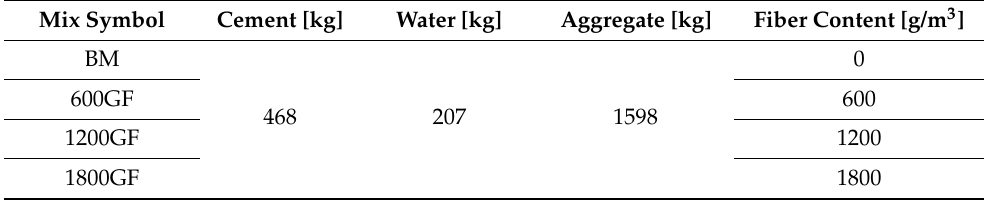
Table 4. Mix proportions (1 m 3 )